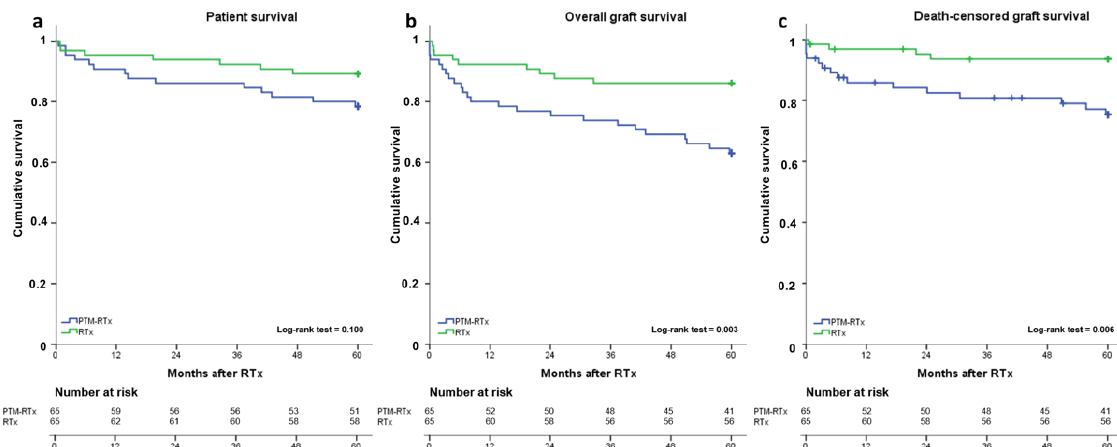
Figure 2. Kaplan-Meier curves for five-year patient and graft survival. Longitudinal patient ( a ), overall graft ( b ) and death-censored graft survival ( c ) stratified for pretransplant malignancy (PTM) renal transplantation (RTx)-recipients and RTx-recipients, respectively. Survival rates of RTx-(green lines) and PTM-RTx-recipients (blue lines) were estimated by Kaplan-Meier methodology and compared by log-rank test. Table 5. Cox proportional hazards regression model with logistic regression analysis of five-year death censored and overall graft